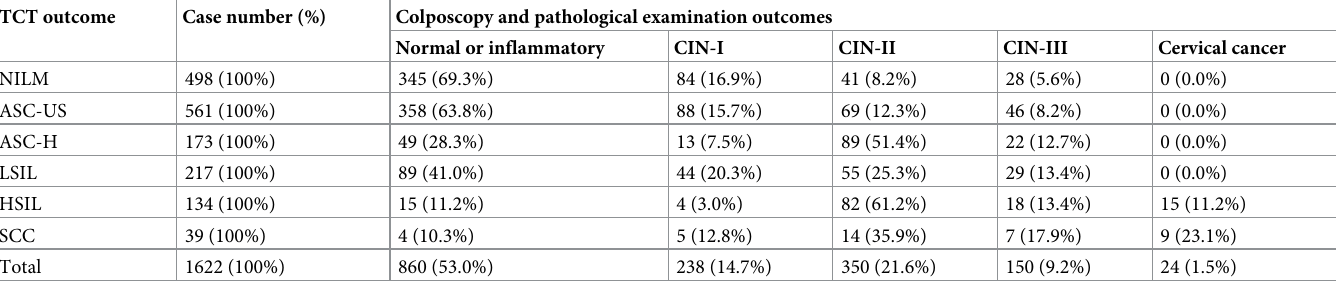
Table 2. Analysis of the TCT outcomes and pathological examination outcomes for 1622 patients with cervical lesions.